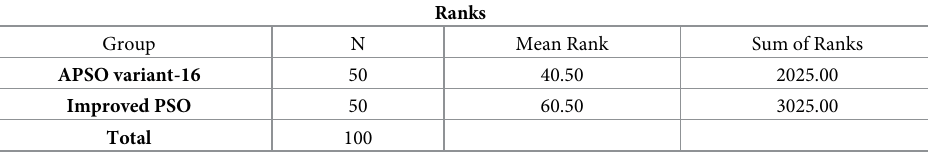
Table 9. Rank statistics of non-parametric Mann Whitney U test for the CSTHTS problem.